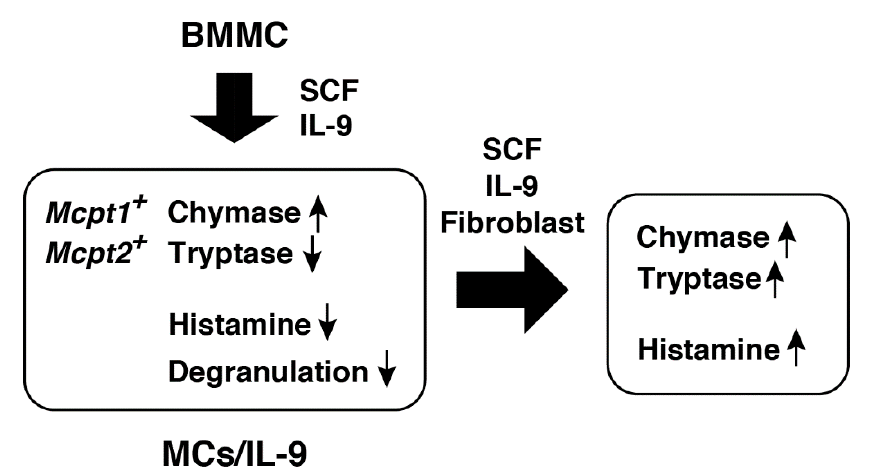
Figure 6. IL-9 has an impact on the characteristics of murine bone-marrow-derived cultured mast cells. The combination of SCF and IL-9 induced the expression of Mcpt1 and Mcpt2 in murine bone-marrow-derived cultured mast cells, as reported previously, and significantly suppressed the histamine synthesis and storage. IL-9-modified mast cells (MCs/IL-9) were less sensitive to ATP and the antigen in degranulation. The presence of fibroblasts recovered the histamine synthesis and tryptase expression.